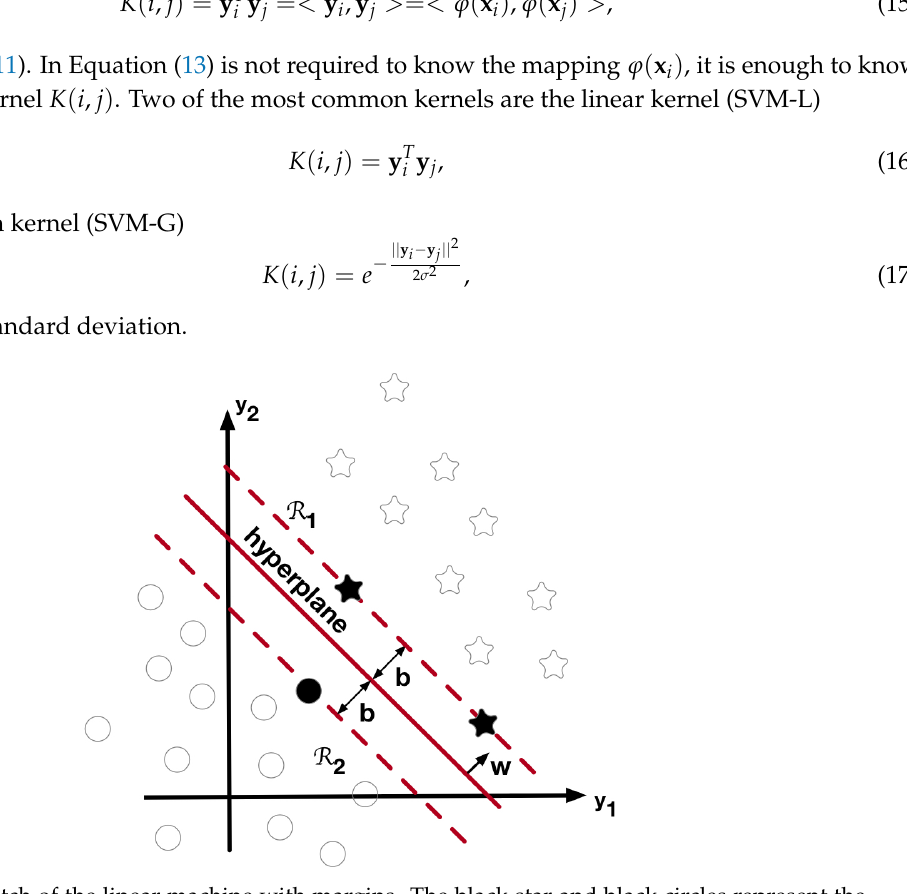
Figure 6. Sketch of the linear machine with margins. The black star and black circles represent the support